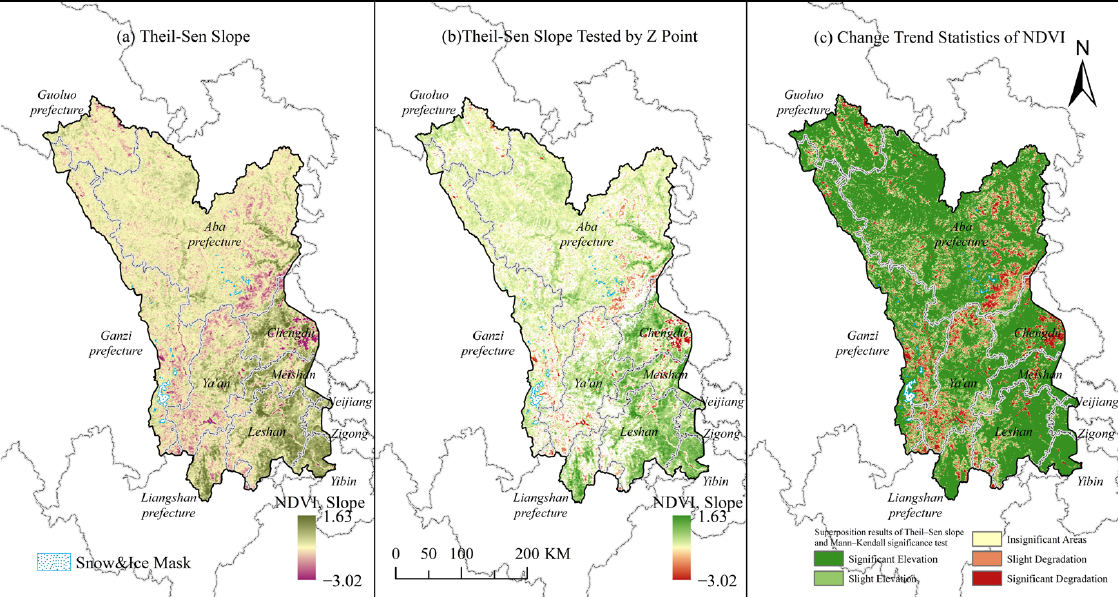
Table 2. Classification table of NDVI change trend from 2001 to 2020.